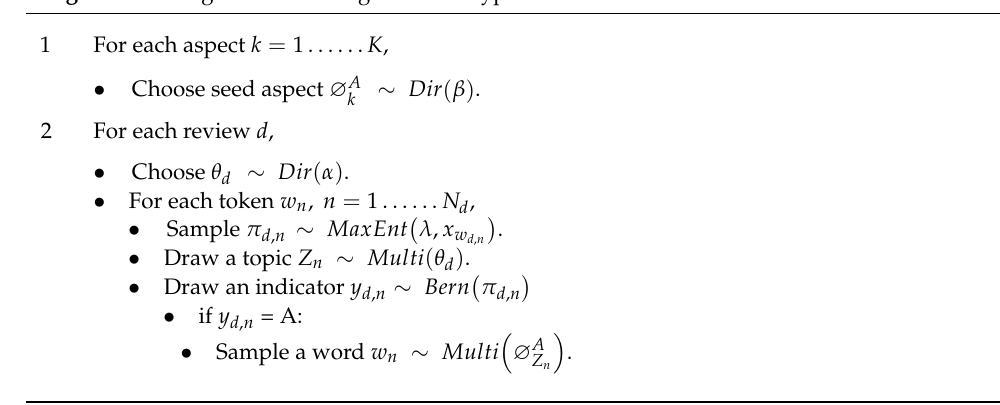
Algorithm 2 : Algorithm for the generative hypothesis